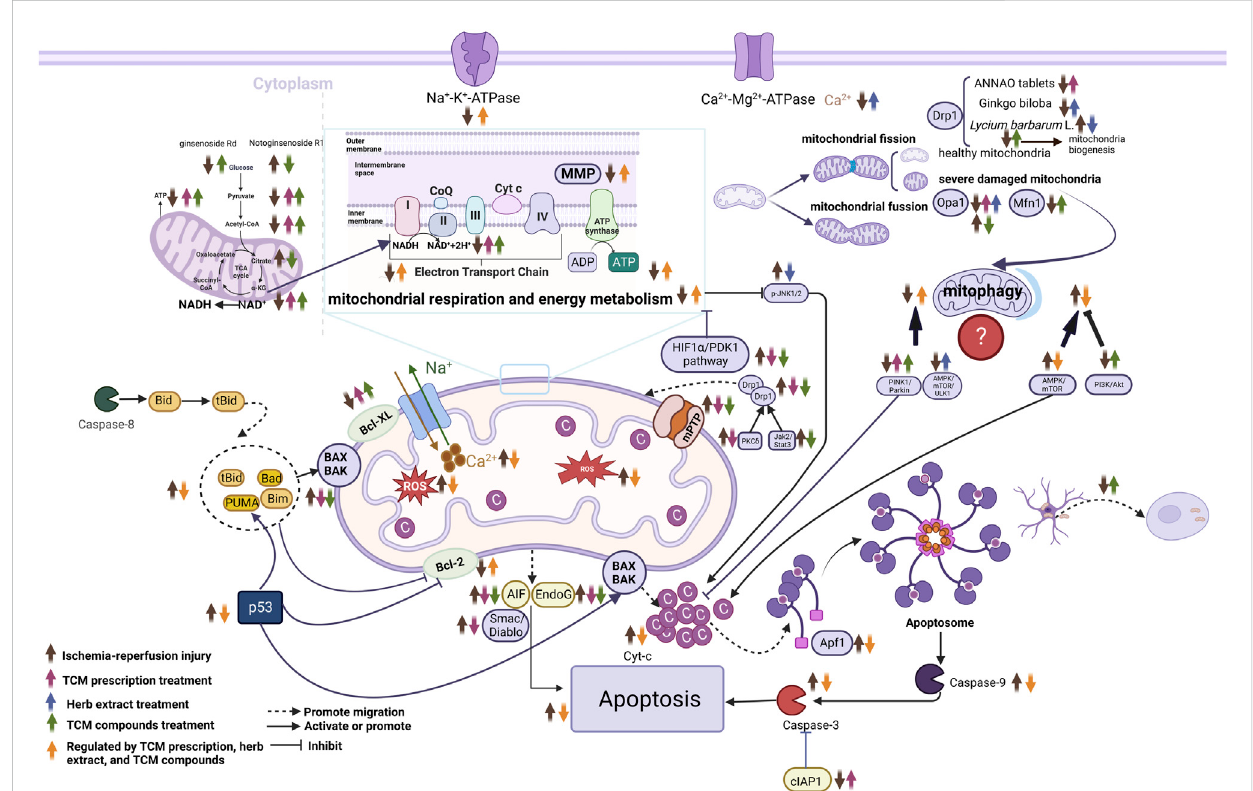
FIGURE 3 Molecularmechanismsofherbalextract,TCMcompoundsandTCMprescriptionsintreatingischemicstrokefromtheprospectiveofmitochondria. ↑ , upregulate; ↓ ,downregulate;Abbreviations:NAD + ,nicotinamideadenine dinucleotide;EndoG,endonucleaseG;Apaf-1,apoptosisactivating factor-1; AIF, apoptosis-related proteins; Mfn1, mitofusins-1; Opa1, optic atrophy 1; Smac/Diablo, the second mitochondrion-derived activator of caspase/direct inhibitorofapoptosis-bindingproteinwithlowpI;cIAP-1,cellularinhibitorofapoptosis-1;Cyt-c,cytochromeC;mPTP,mitochondrialpermeability transitionpore;MMP,mitochondrial membranepotential;AMPK,AMP-activatedproteinkinase;mTOR,mammaliantargetofrapamycin;Drp1,dynamin- related protein 1; HIF1 α /PDK1, Hypoxia-Inducible Factor 1-Alpha/Pyruvate Dehydrogenase Kinase 1; NADH, Nicotinamide adenine dineucleotide; JNK, c-Jun N-terminal kinase; ROS, reactive oxygen species; TCA, tricarboxylic